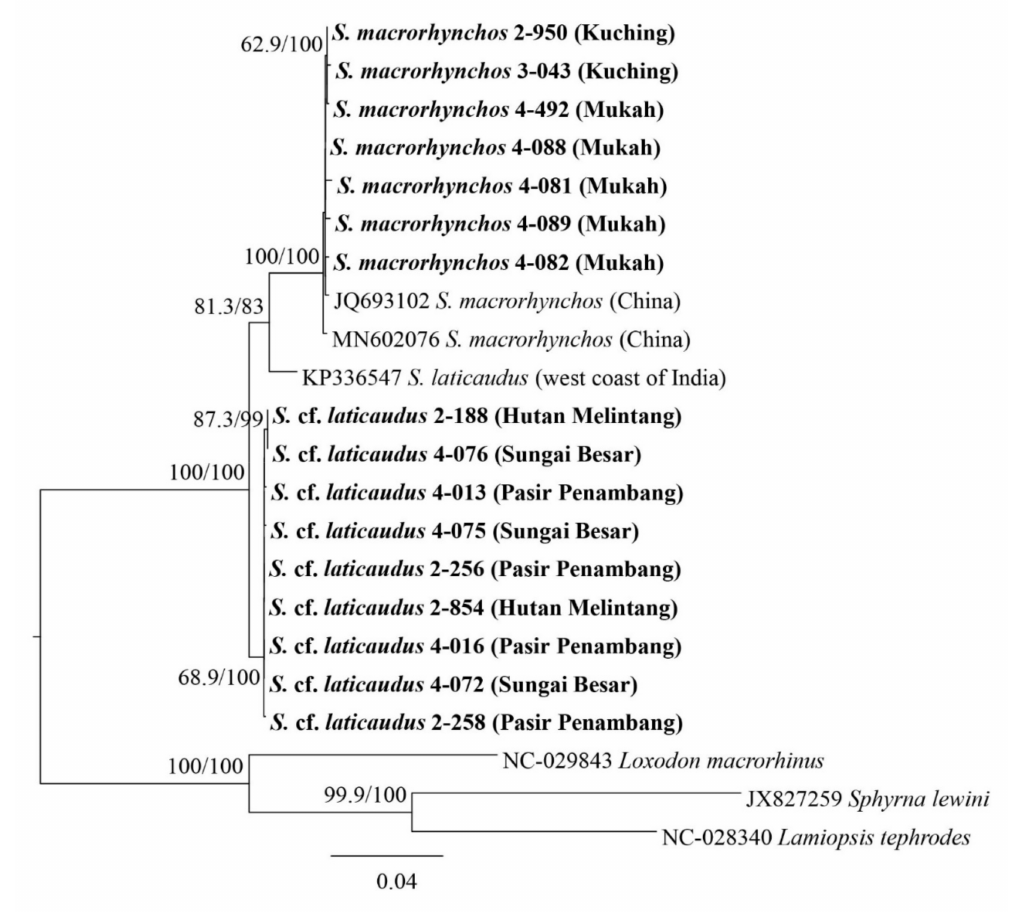
Figure 2. NADH2COI gene mid-point rooting phylogenetic relationships of Scoliodon ‘species’ (phylogram). The bootstrap values (ML/BI) are shown at branches. Sequence names in bold are from the present